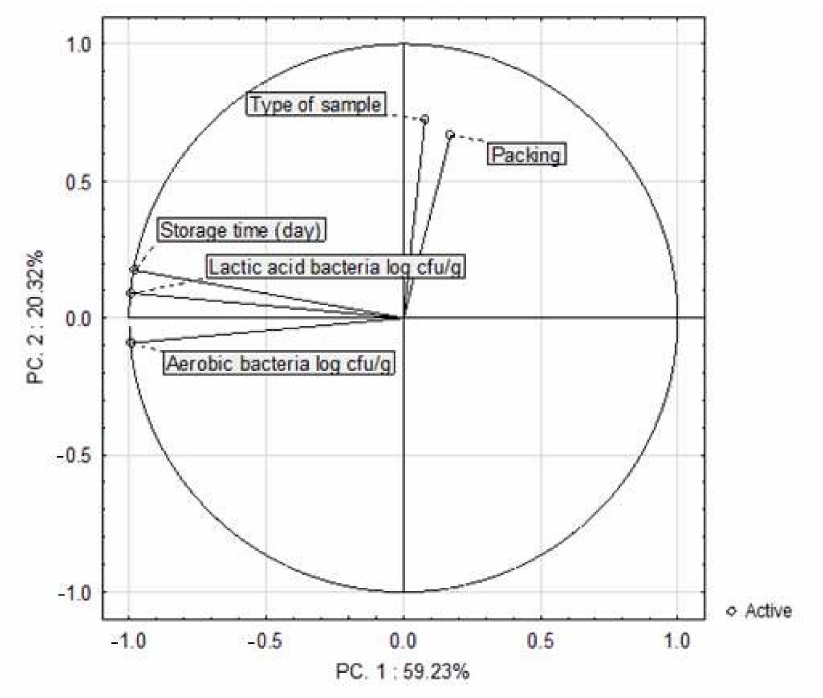
Figure 7. Changes in the value of the total colony count (TCC) and the count of mesophilic lactic acid bacteria (LAB) in the poultry sausages depending on the type of packing and time of storage ( n =